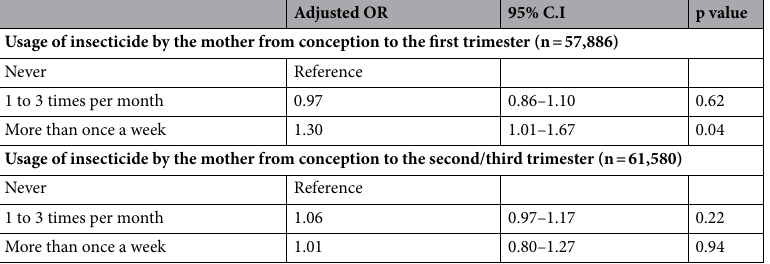
Table 2. Association between history of otitis media in the first year in children and maternal insecticide use from conception to the first (upper) and the second/third (lower) trimesters. OR odds ratio, 95% C.I. 95% confidence interval. These analyses were adjusted for sex, exclusive breastfeeding for the first 6 months, maternal age, gestational age, birth weight, living with siblings at 6 months, daycare attendance, maternal history of chronic otitis media, Hib vaccination, pneumococcal vaccination, maternal and paternal smoking history, exposure to secondhand smoke, diagnosis of trisomy 21, fertility treatment, family member’s smoking status, and maternal occupational category.